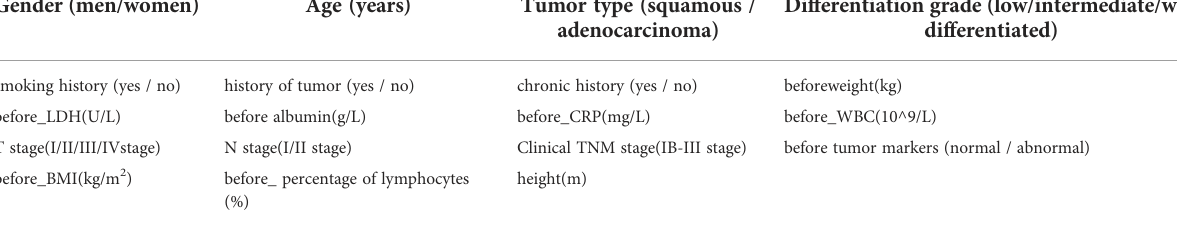
TABLE 5 Clinicopathological information converged with the before_rad_data.